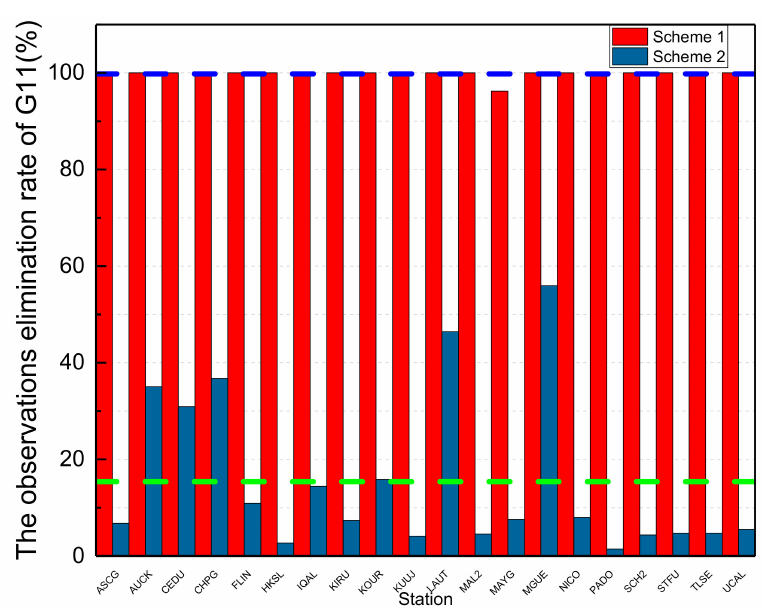
Figure 10. Observation elimination rate of stations for G11 from precise orbit determination on 1 March